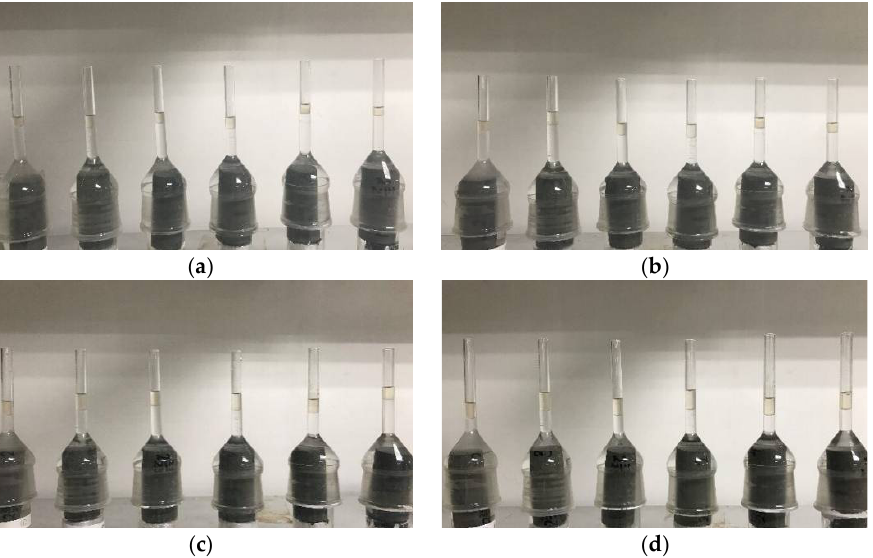
Figure 2. The process of spontaneous imbibition in the tests investigating salinity effects after 4 h ( a ), 8 h ( b ), 18 h ( c ) and 28 h ( d